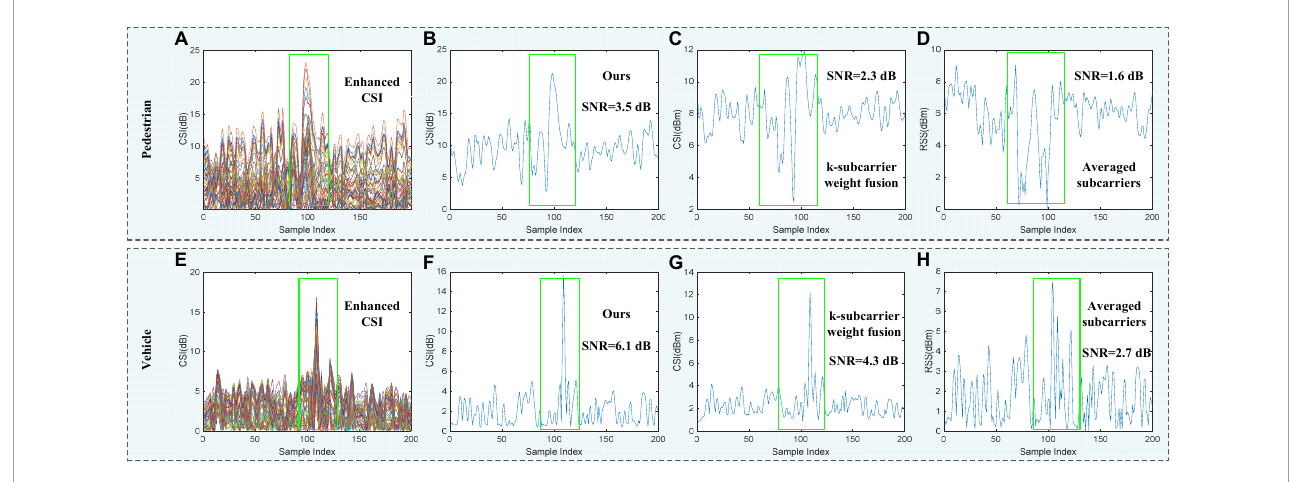
FIGURE5 Different CSI subcarrier selection method. (A,E) Represent the enhanced raw CSI waveforms of the vehicle and pedestrian, respectively. (B–D,F–H) Represent the CSI waveforms of the vehicle and pedestrian generated by the three subcarrier selection methods, respectively.